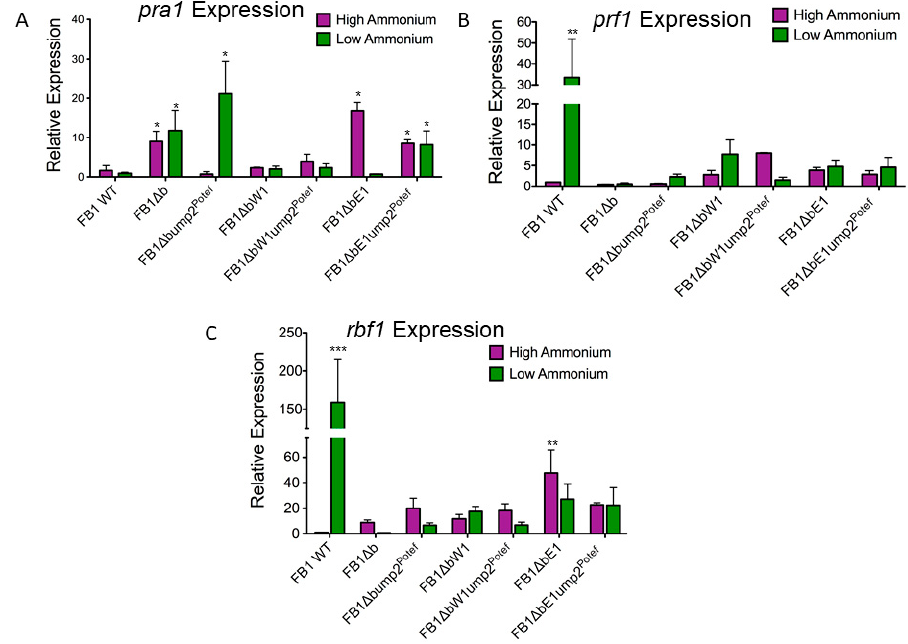
Figure 4. Change in expression of other mating related targets. The transcript level of pra1 ( A ), prf1 ( B ), and rbf1 ( C ) were evaluated in different b deletion strains without and without constitutive expression of ump2 . Changes in gene expression are averages of at least three biological replicates and are displayed as log2-fold changes ± S.D., relative to expression of wild-type FB1 on High NH 4 . Relative expression of each strain and/or condition was compared to the reference strain. All of the analyses were done using a one-way ANOVA with a Dunnett’s multiple comparison post hoc test. (* p < 0.05, ** p < 0.01, and *** p <